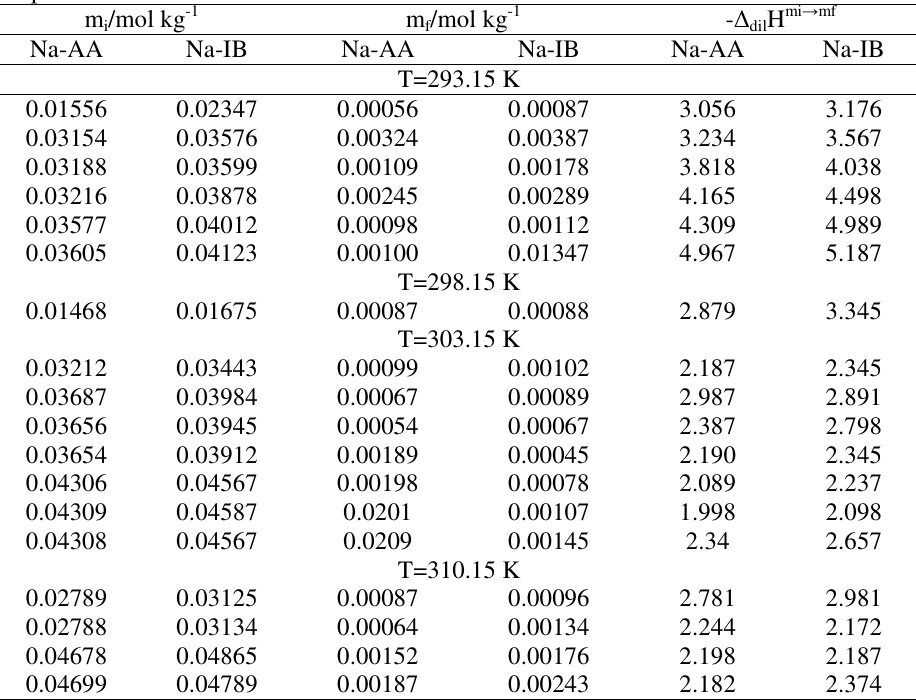
H mi → mf , kJ mol -1 , of Na-AA and Na-IB in water at various dil